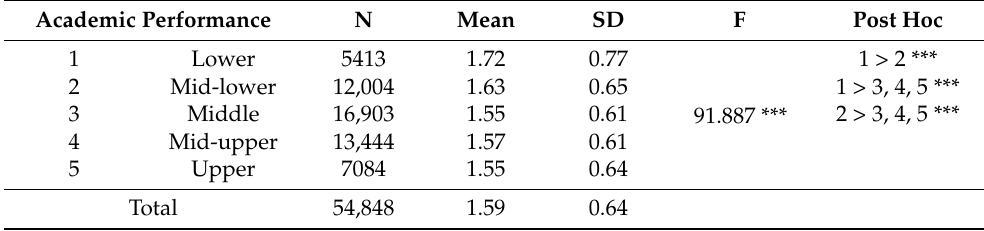
Table 4. Comparison of mean GAD scores by academic performance.